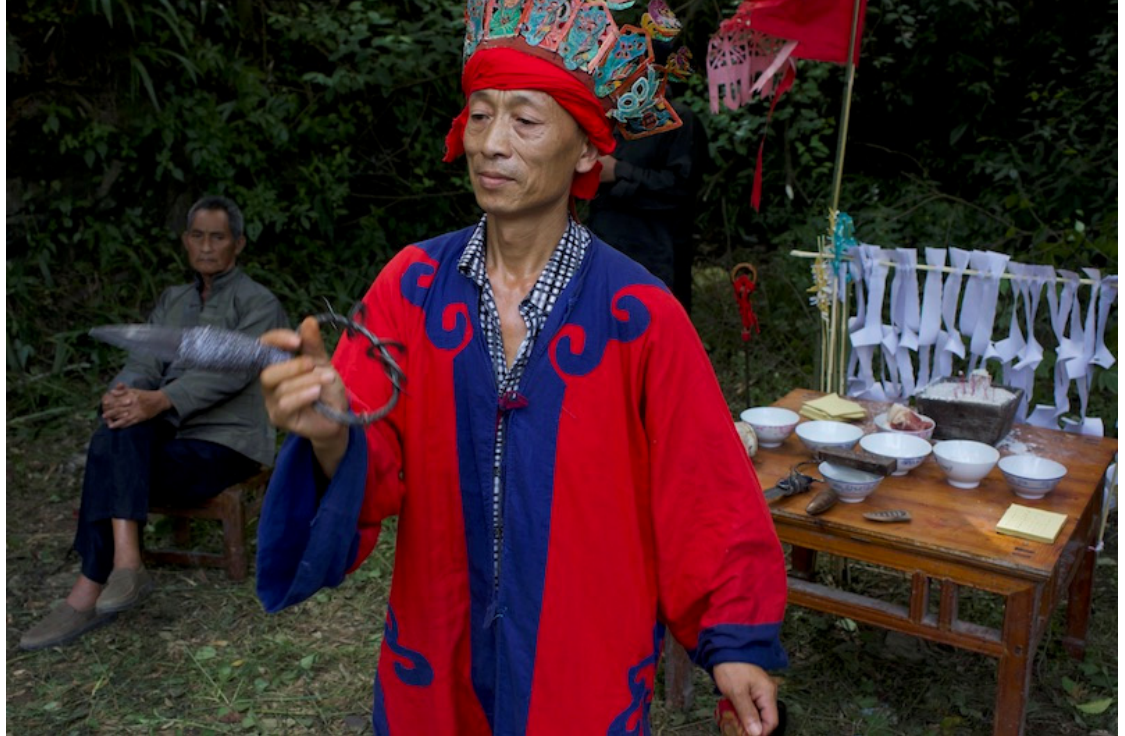
Figure 20. Badai Yang with a shidao knife in front of the sacrificial altar. The shidao also serves as a noise maker to attract the spirits. (Photo: Thomas Riccio).